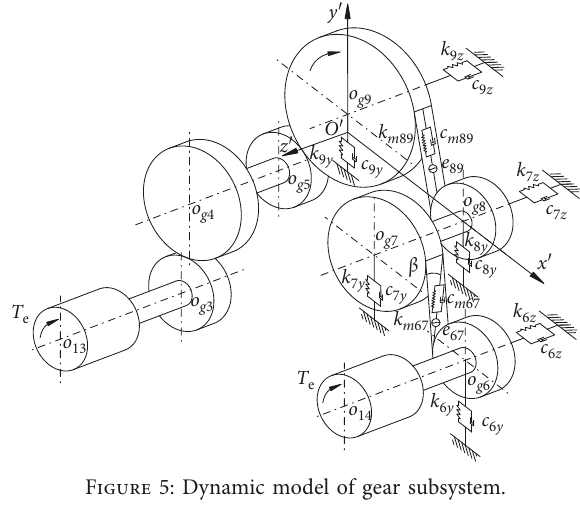
Figure 5: Dynamic model of gear